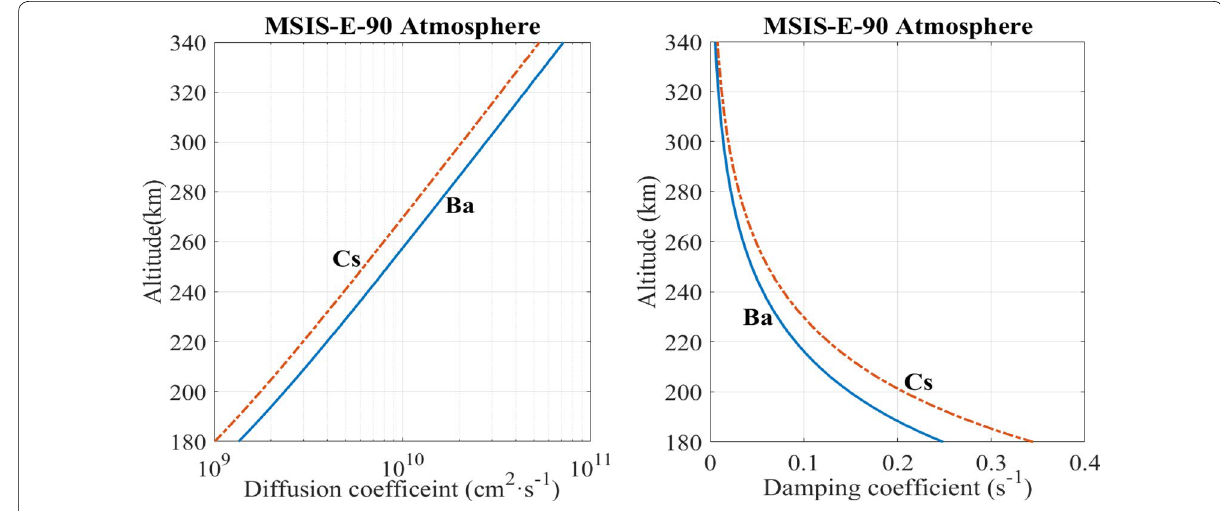
Fig. 9 Comparison of the diffusion coefficient (left) and damping coefficient (right) of Cs and Ba